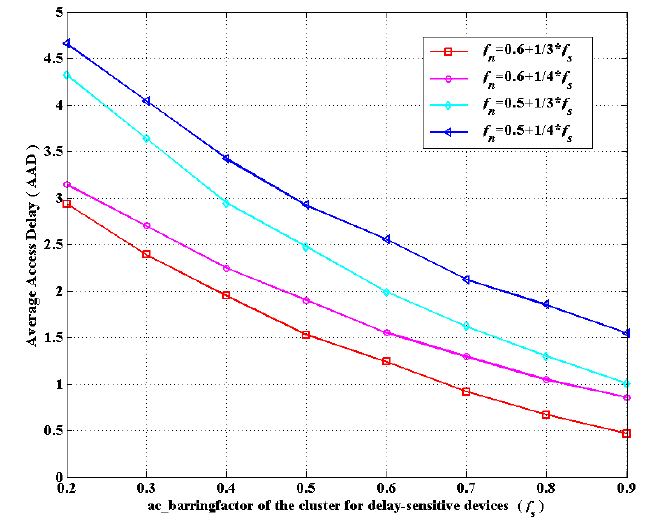
Figure 7. The average access delay (AAD) versus the linear correlation of f s and f n